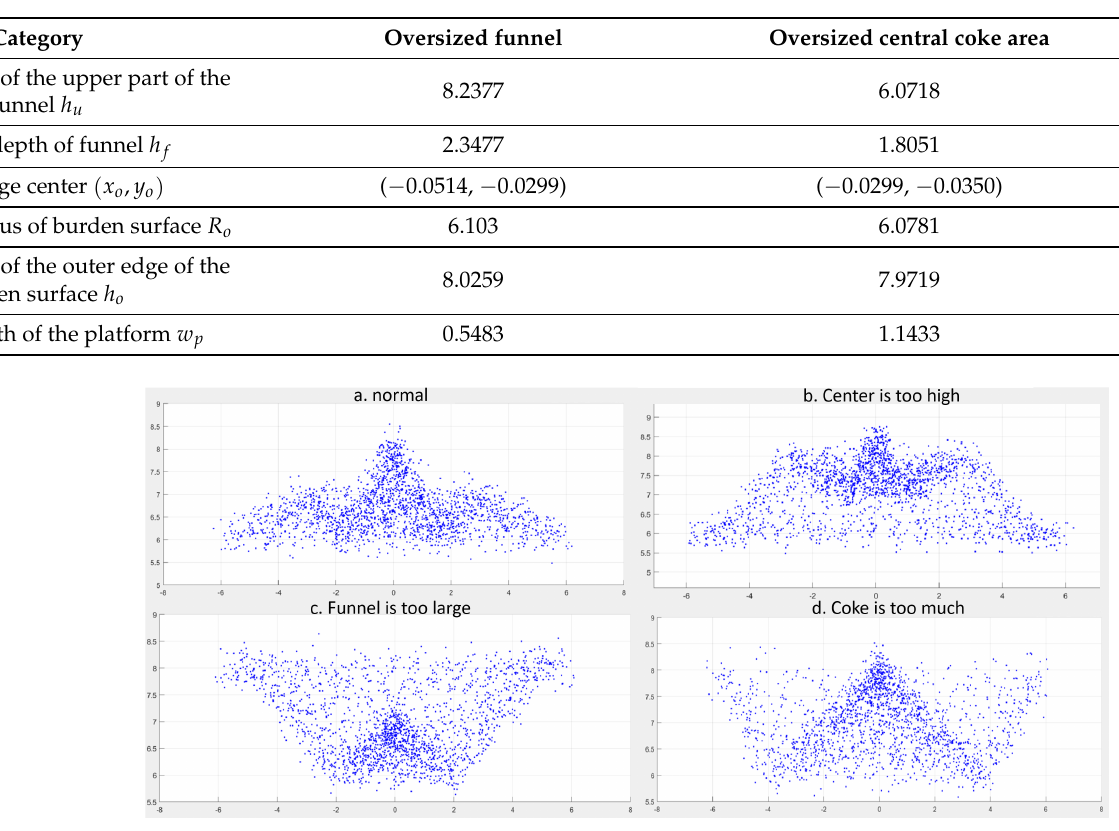
Figure 11. Four types of burden surfaces.